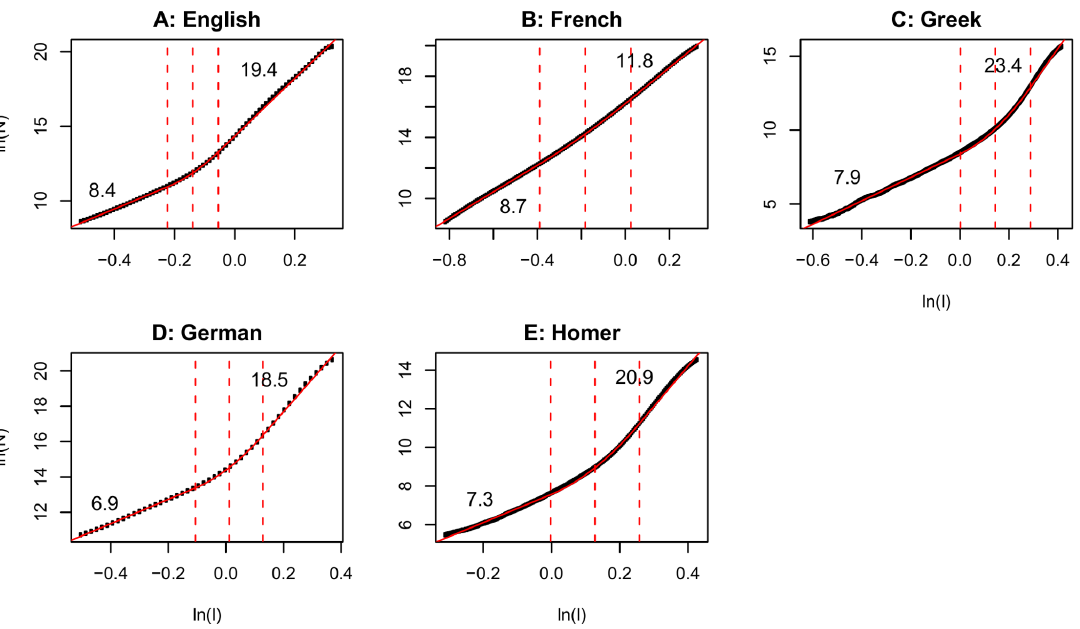
Figure 6. Correlation dimension of natural language discourse (reproduced with permission from Doxas, Dennis & Oliver, PNAS , 2010 [7] ). Natural language discourse exhibits a two-scaled geometry with a smaller dimension at shorter length scales and a larger dimension at longer scales. Figure 3 and Figure S6 show that visual experience has a similar two-scaled structure.